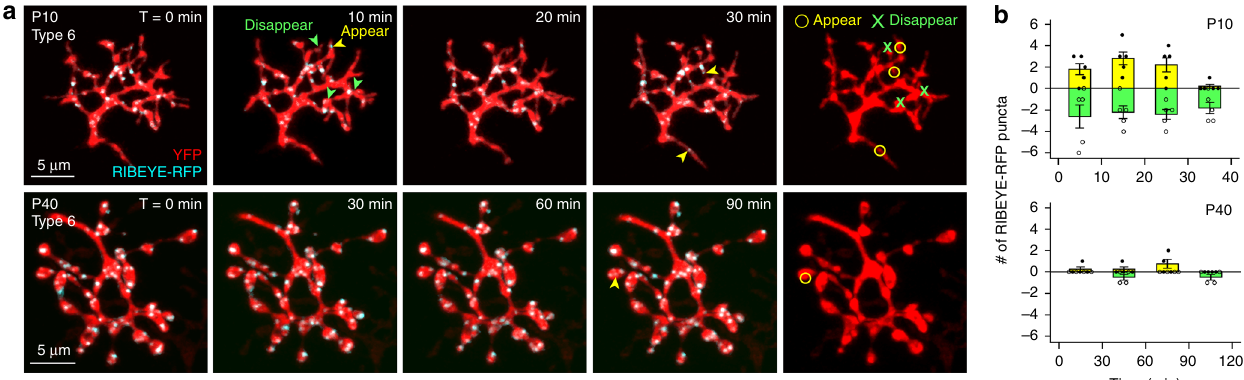
Fig. 3 Dynamics of ribbons on axon terminals of BCs in developing and mature retinas. a Live imaging of ribbons within individual T6 BC axon terminals in RIBEYE-tagRFP × Grm6-YFP retinas. All RIBEYE-tagRFP-T puncta that appeared or disappeared during the imaging session were identi fi ed. Yellow arrow: punctum appeared; Green arrow: punctum disappeared. b Quanti fi cation of the number of RIBEYE-tagRFP-T puncta that were formed or were eliminated at P10 ( fi ve cells from three retinas) or at P40 (four cells from two retinas). Filled circle and yellow bar: puncta formed; Open circle and green bar: puncta eliminated. Data are presented as mean ± sem